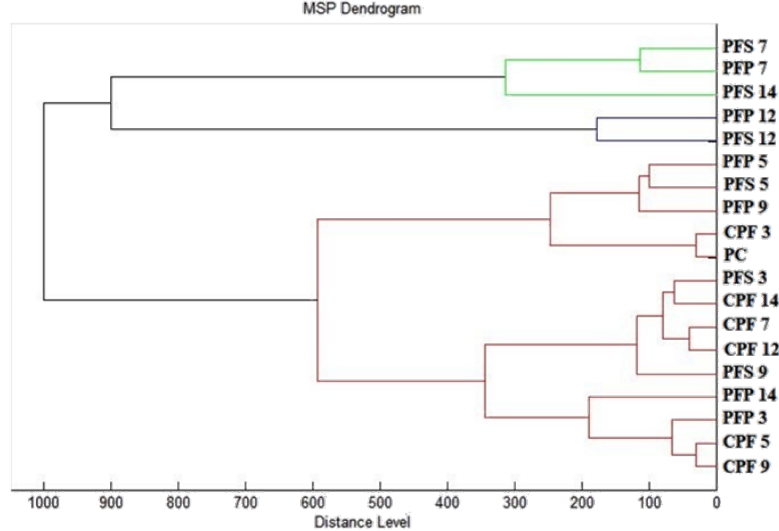
Figure 2. Dendrogram of P. fluorescens biofilm progress after EGEO exposition. PF — P. fluorescens ; C — control; S — stainless steel; P — plastic; P — planktonic cells.